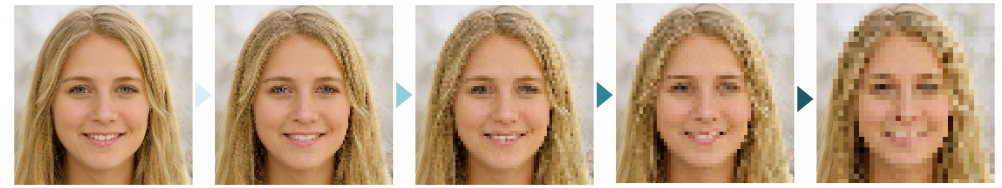
Figure 3. The privacy and